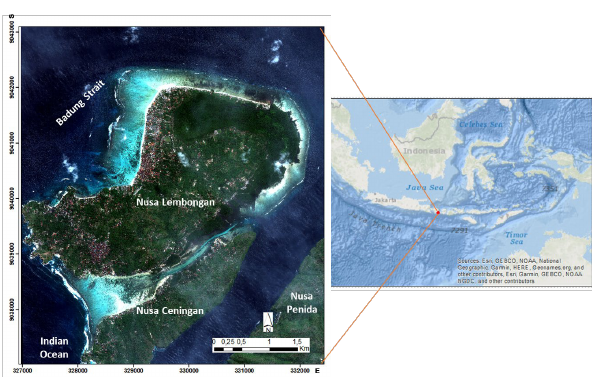
Figure 1 . Nusa Lembongan, Bali